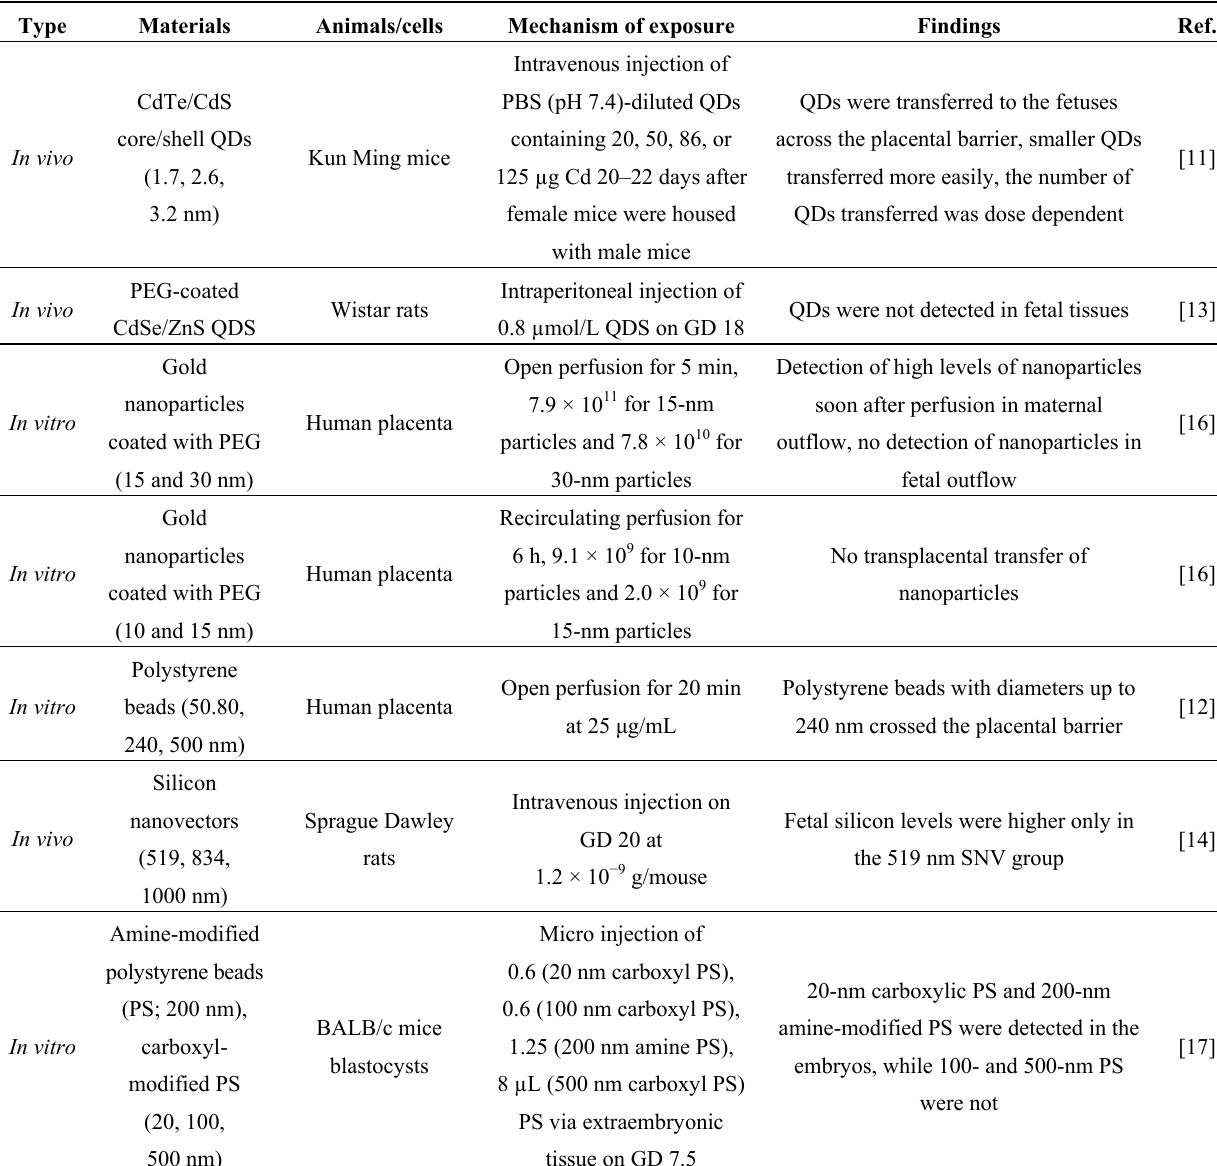
Table 1. Transfer of nanoparticles to